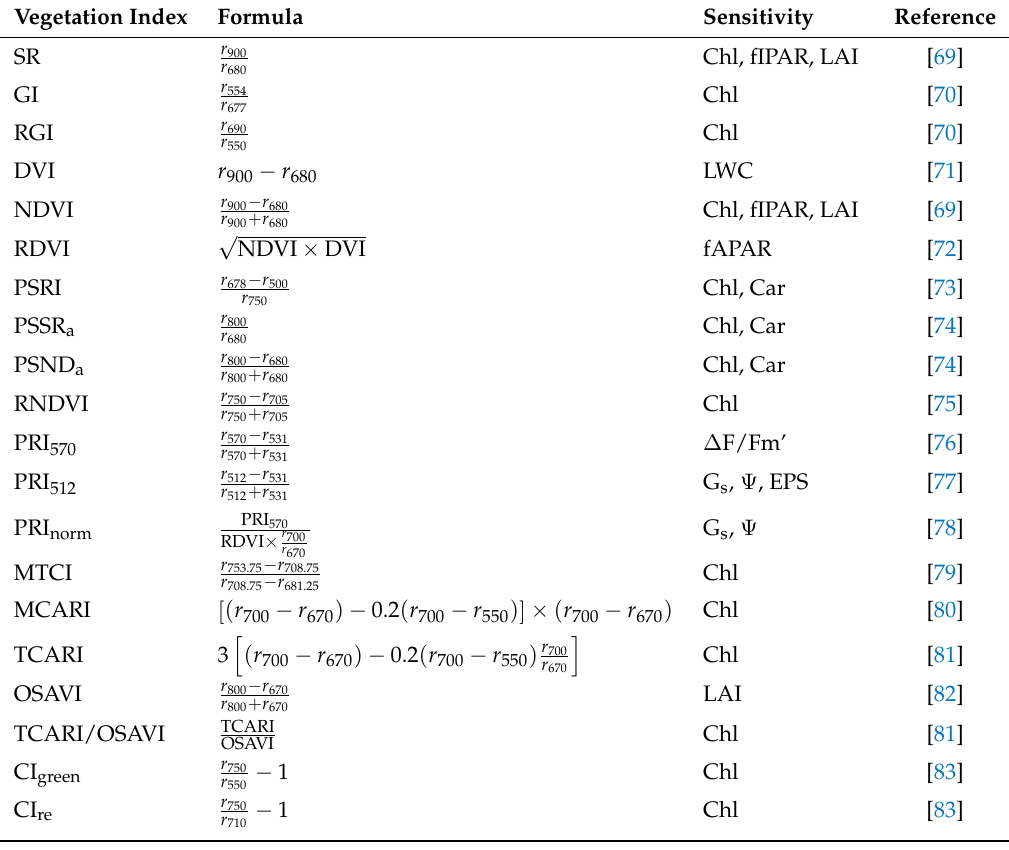
Table 2. Vegetation indexes used in the study, and their reported sensitivities to biochemical, physiological, and structural plant